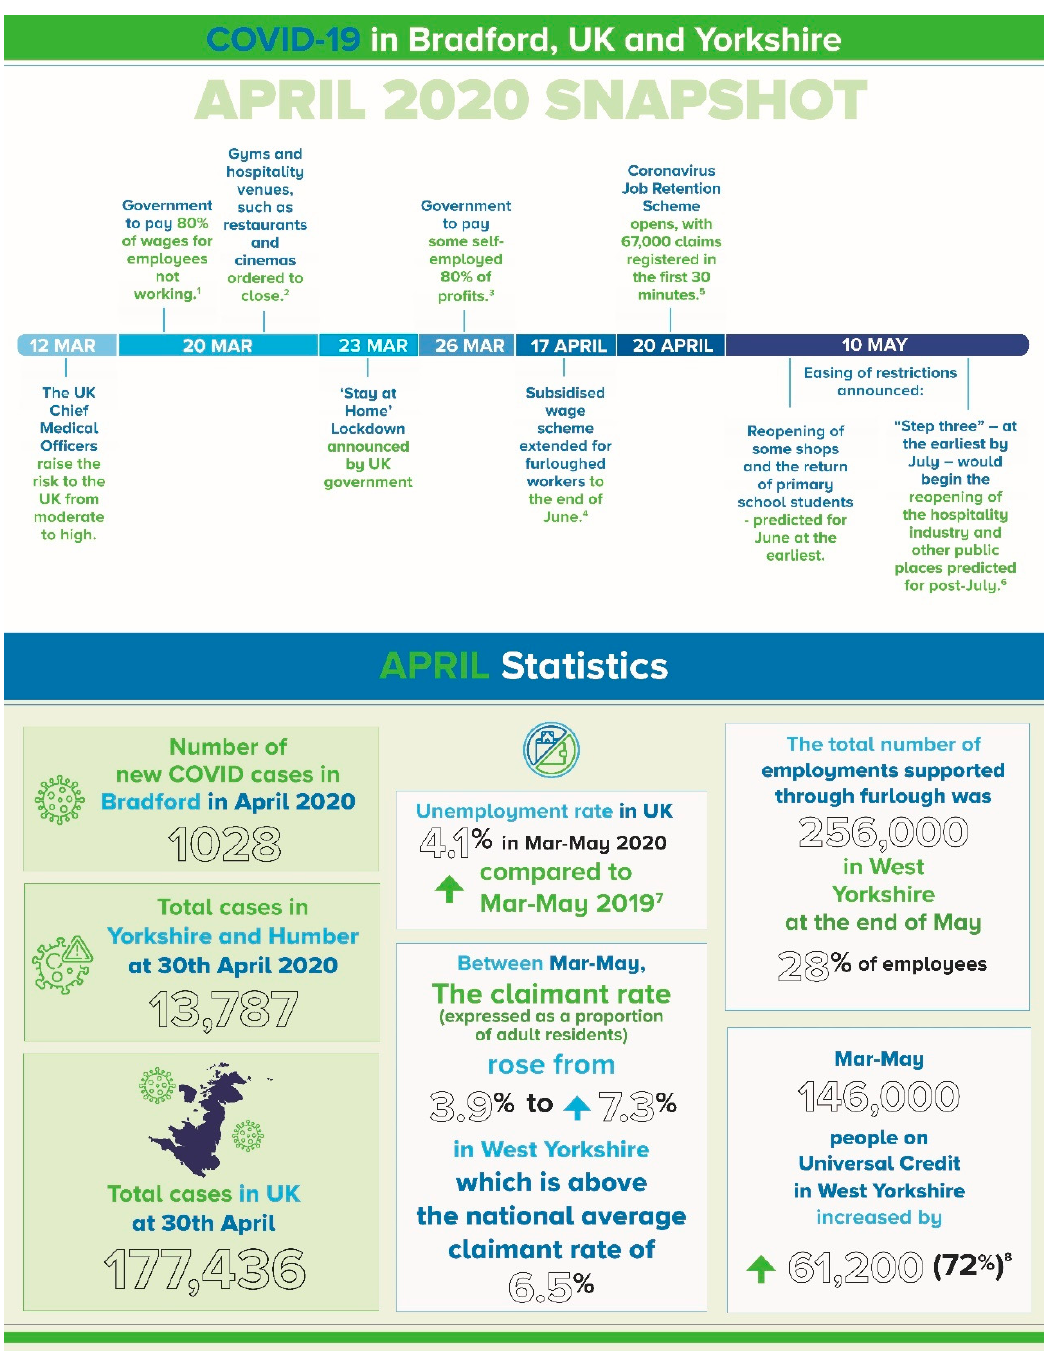
Figure 2. Timeline and Snapshot of COVID-19 events in Bradford, UK, as they affected the BiB participants. Sources: https://coronavirus.data.gov.uk/details/cases . 1 “Wages cover for businesses hit by virus outlined”. BBC News. 20 March